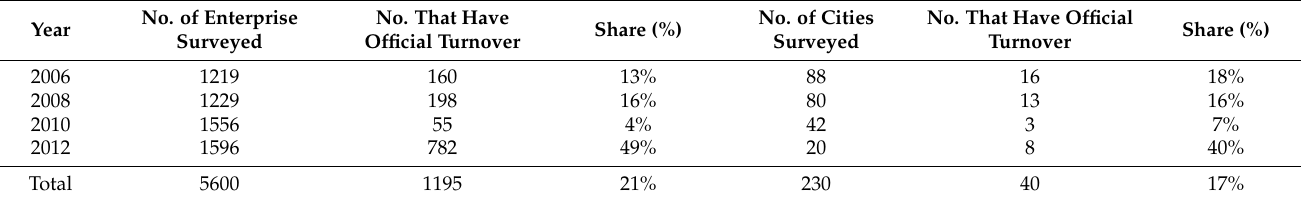
Table A1. A summary of local official transfers during the research period.